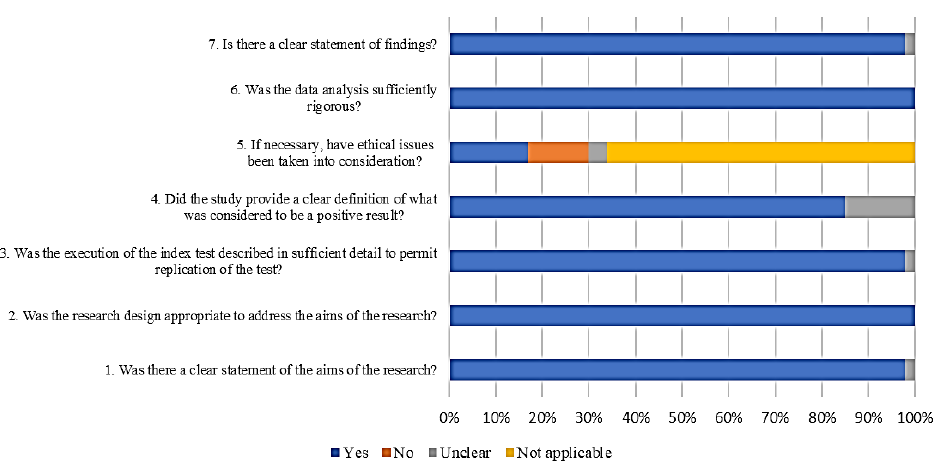
Figure 2. Quality assessment of the retrieved studies.